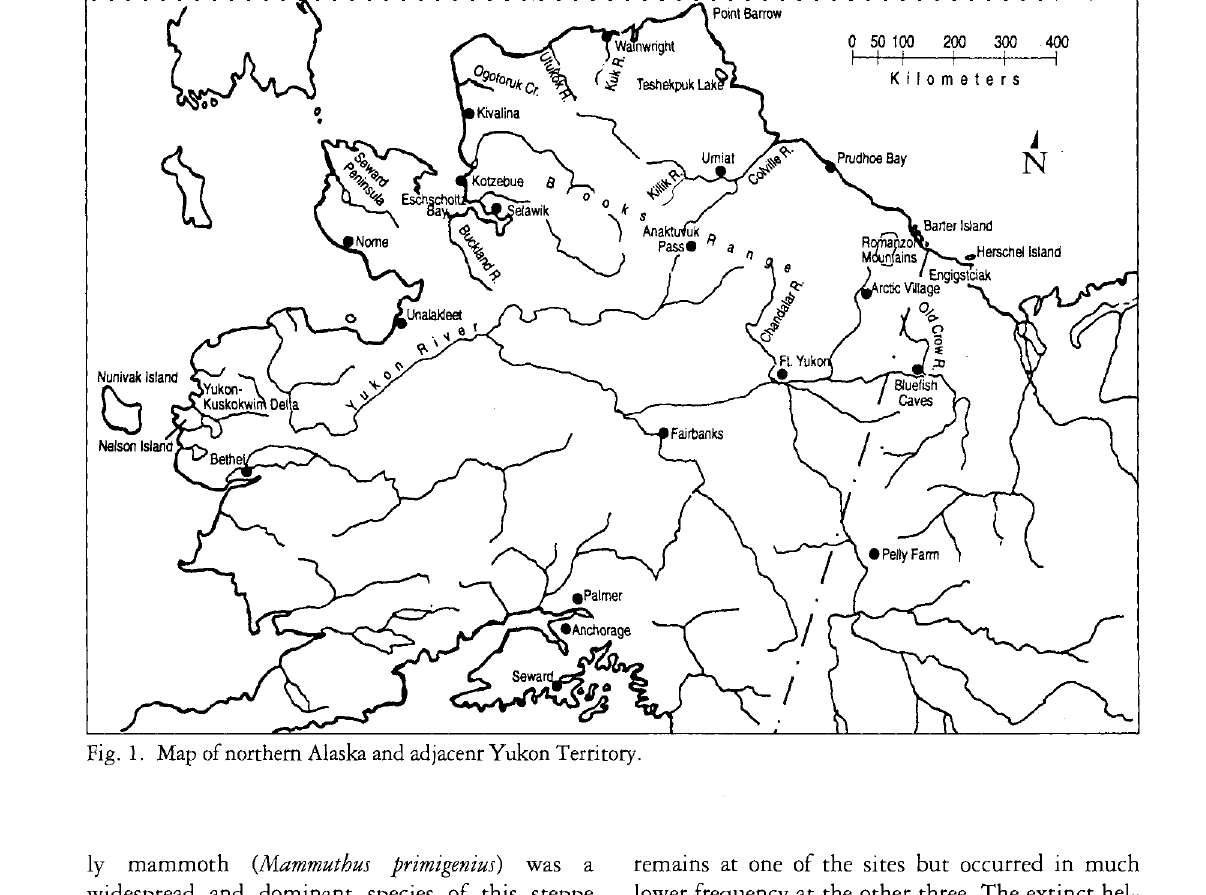
Fig. 1. Map of northern Alaska and adjacenr Yukon